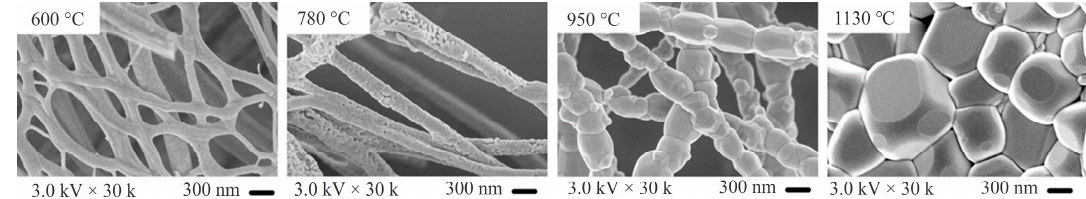
Figure 8. SEM images of CaCu 3 Ti 4 O 12 composite NFs calcined at different temperatures. Reprinted